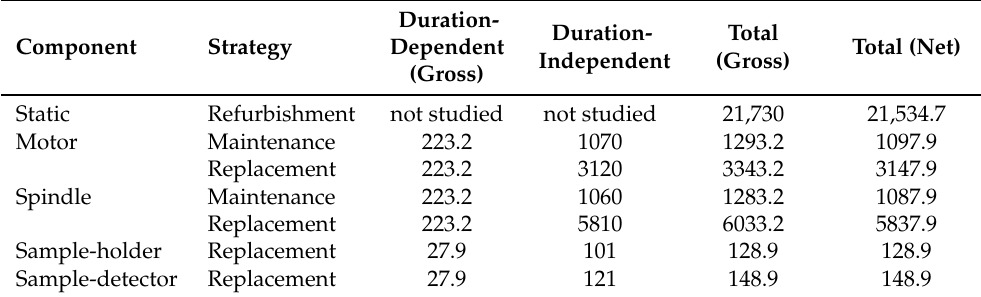
Table 11. Direct costs (EUR) during strategies for the friction welding machine